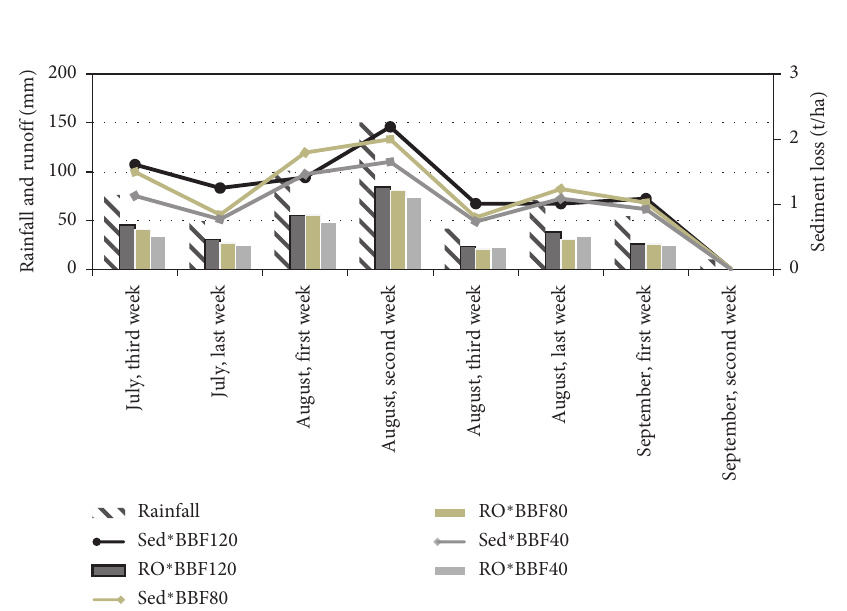
Figure 4: The periodical behavior of rainfall, runoff, and sediment yield for the year 2017 growing season (RO: runoff; Sed: